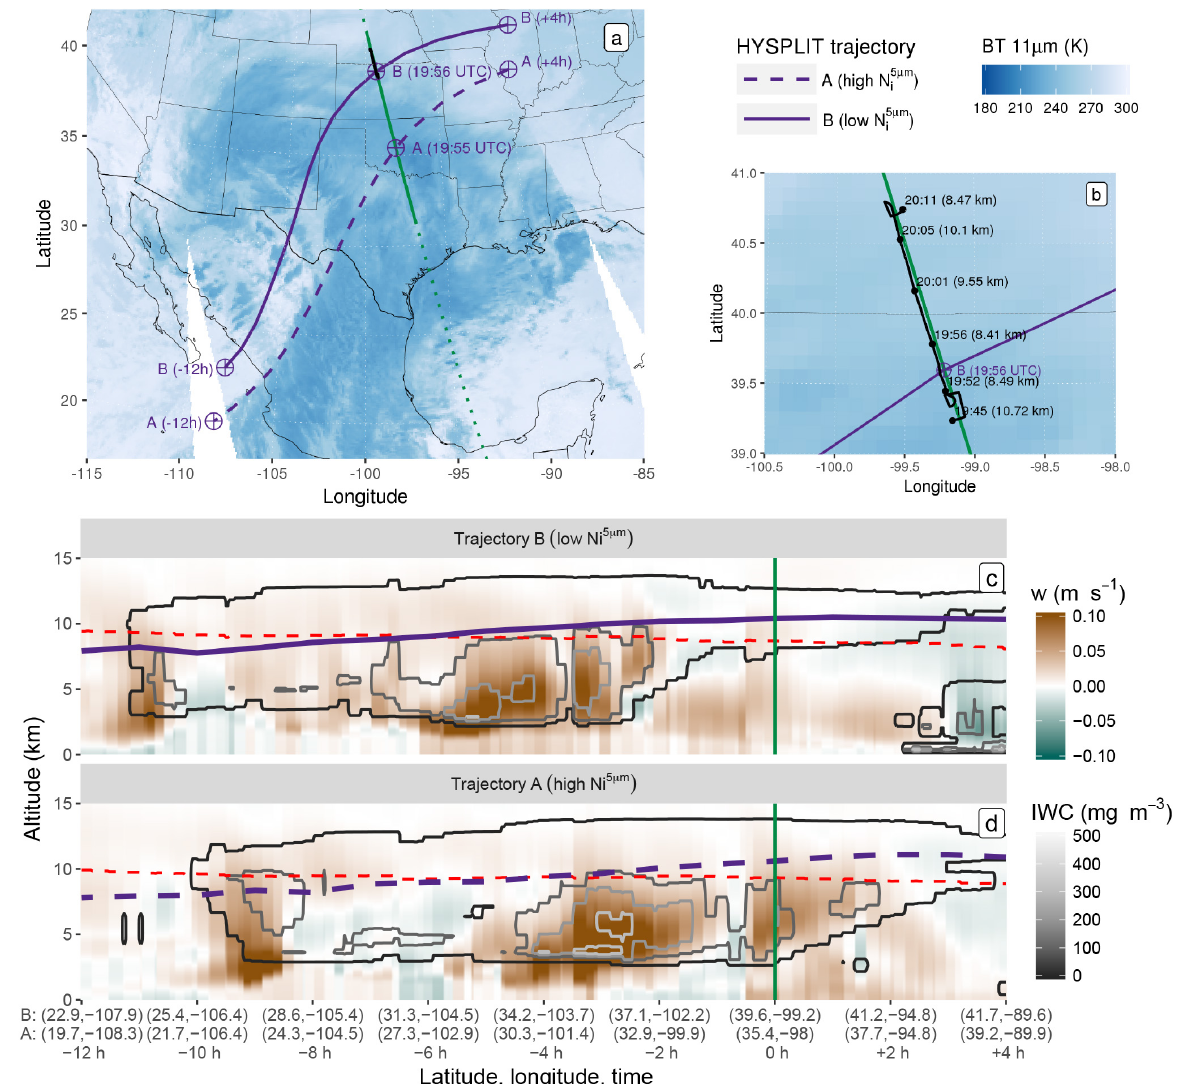
Figure 5. (a) Map summarizing the observations during the case study. The shaded blue background corresponds to MODIS/Aqua 11µm brightness temperature measurements around the A-Train overpass. The CloudSat track is shown by a dotted green line, and a plain green line highlights the region of interest. The Learjet 25 flight track is shown in black. Dashed and plain purple lines represent HYSPLIT trajectories computed for two air parcels of high (A) and low (B) N 5µm , respectively, at 11 km along the overpass. (b) Similar to (a) but i zoomed in around the flight area. The aircraft times (in UTC) and altitudes are indicated in black. (c–d) Vertical cross sections of vertical wind velocities ( w ; background color) and IWC (grey contours) predicted by NARR along the B and A trajectories, respectively. The posi- tions of the corresponding air parcels are indicated in purple. A dashed red line shows the − 40 ◦ C isotherm. The overpass time is highlighted by a vertical green